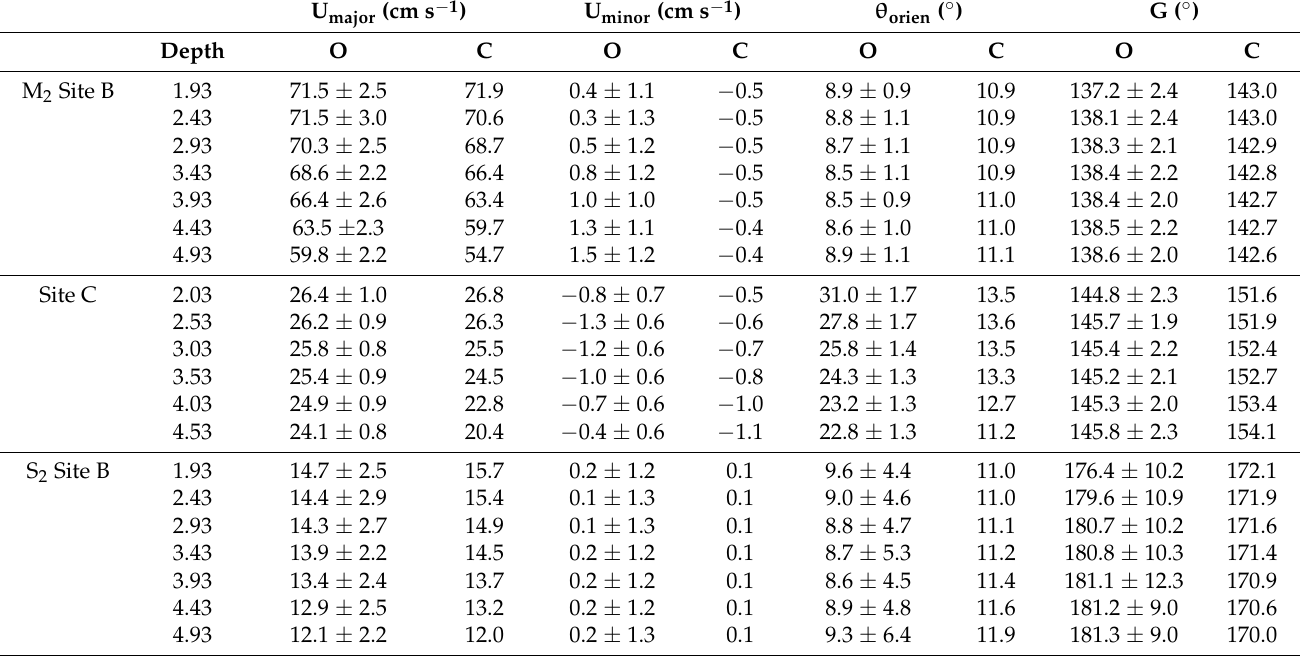
Figure 6. Comparison between model-computed and observed vertical profiles of the major axis, minor axis, orientation, and phase of the M 2 , S 2 , N 2 , K 1 , and O 1 tidal current ellipse at site C. Table 2. Comparison of observed and model-computed M 2 , S 2 , N 2 , K 1 , and O 1 tidal current ellipse parameters at sites B and C.